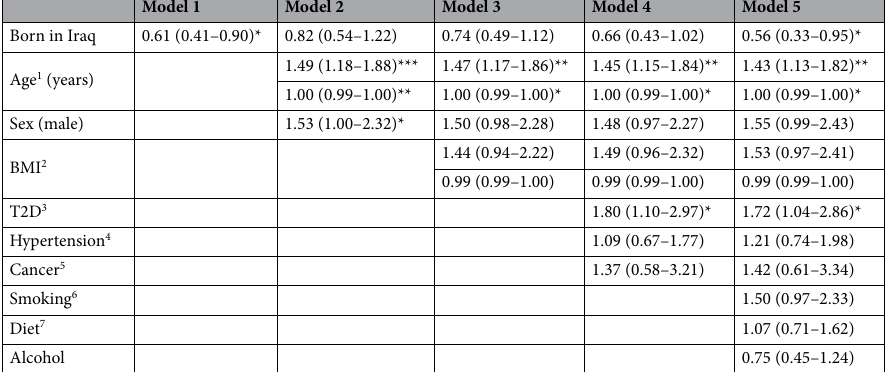
Table 4. Cox regression models showing adjusted HR of CVD events or death from CVD, model 1–5, 95.0% CI for Exp(B). 1 Linear age and age squared, 2 linear BMI and BMI squared, 3 T2D at baseline, 4 hypertension at baseline, 5 cancer at baseline, 6 current tobacco smoking, 7 daily intake of fruit, berries and/or vegetables,